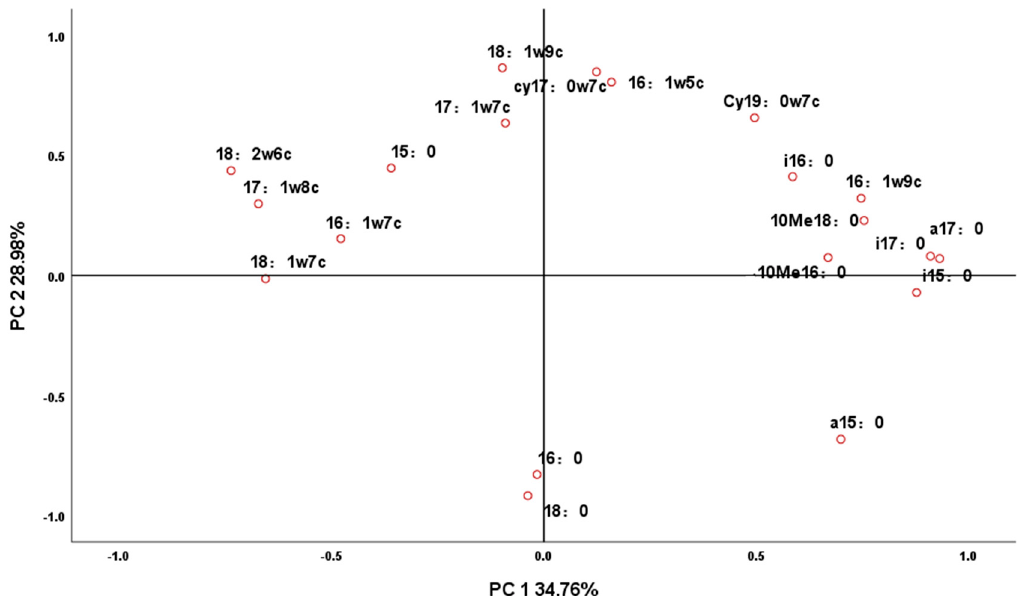
Figure 1. Principal component analysis (PCA) of microbial fatty acids in soil. This figure is a principal component analysis based on the phospholipid fatty acid structure nomenclature. PC: Principal Component. Table 6. Principal component analysis component matrix.